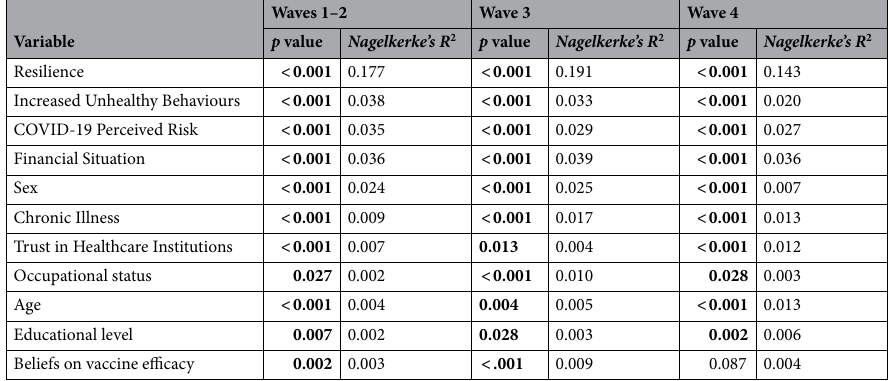
Table 2. Multinomial Logistic regression models output: ranking (based on Nagelkerke’s R 2 ) of the socio- demographic and risk perception variables in discriminating the three well-being groups. Significant values are in